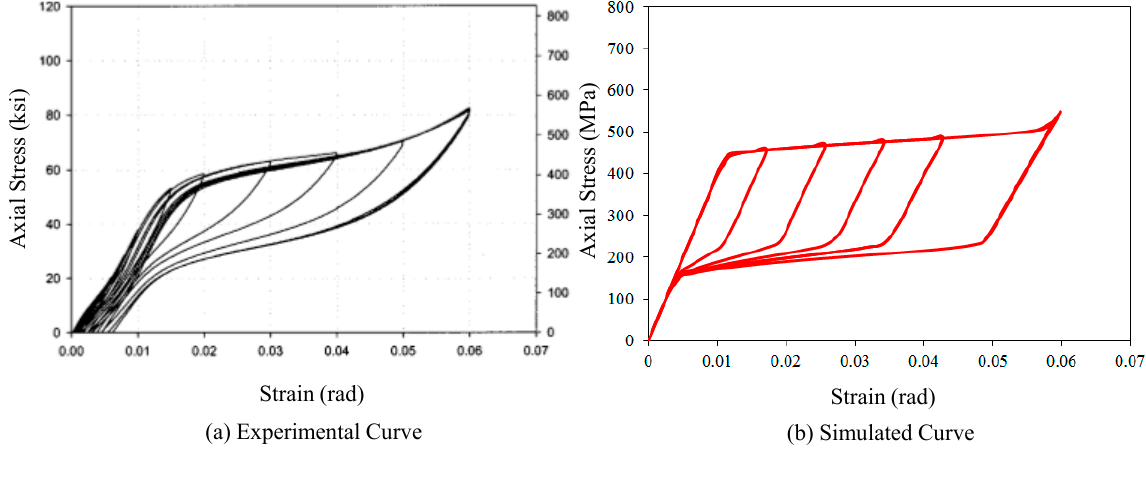
Figure 8. Simulated stress-strain curve for the super-elastic SMA material, ( a ): Experimental Curve; ( b ): Simulated